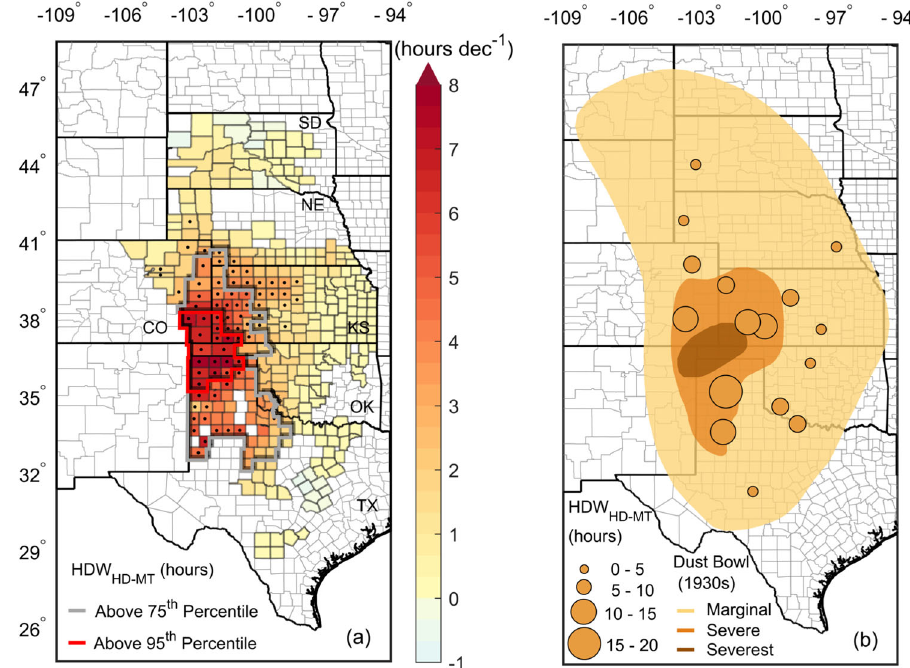
Fig. 1 | Hot-dry-windy events (HDW) trends (hours per decade) during the heading-maturity stage (HDW HD-MT ) from 1982 – 2020 and annual average of HDW HD-MT from climate observing stations. a Annual HDW HD-MT trends for all winter wheat counties; the black dots indicate that HDW trends were statistically signi fi cant; and the gray and red boundaries indicate HDW areas above the